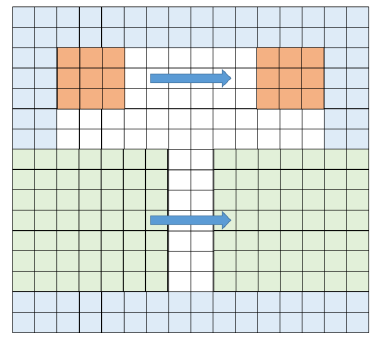
Figure 5. Schematic diagram of edge